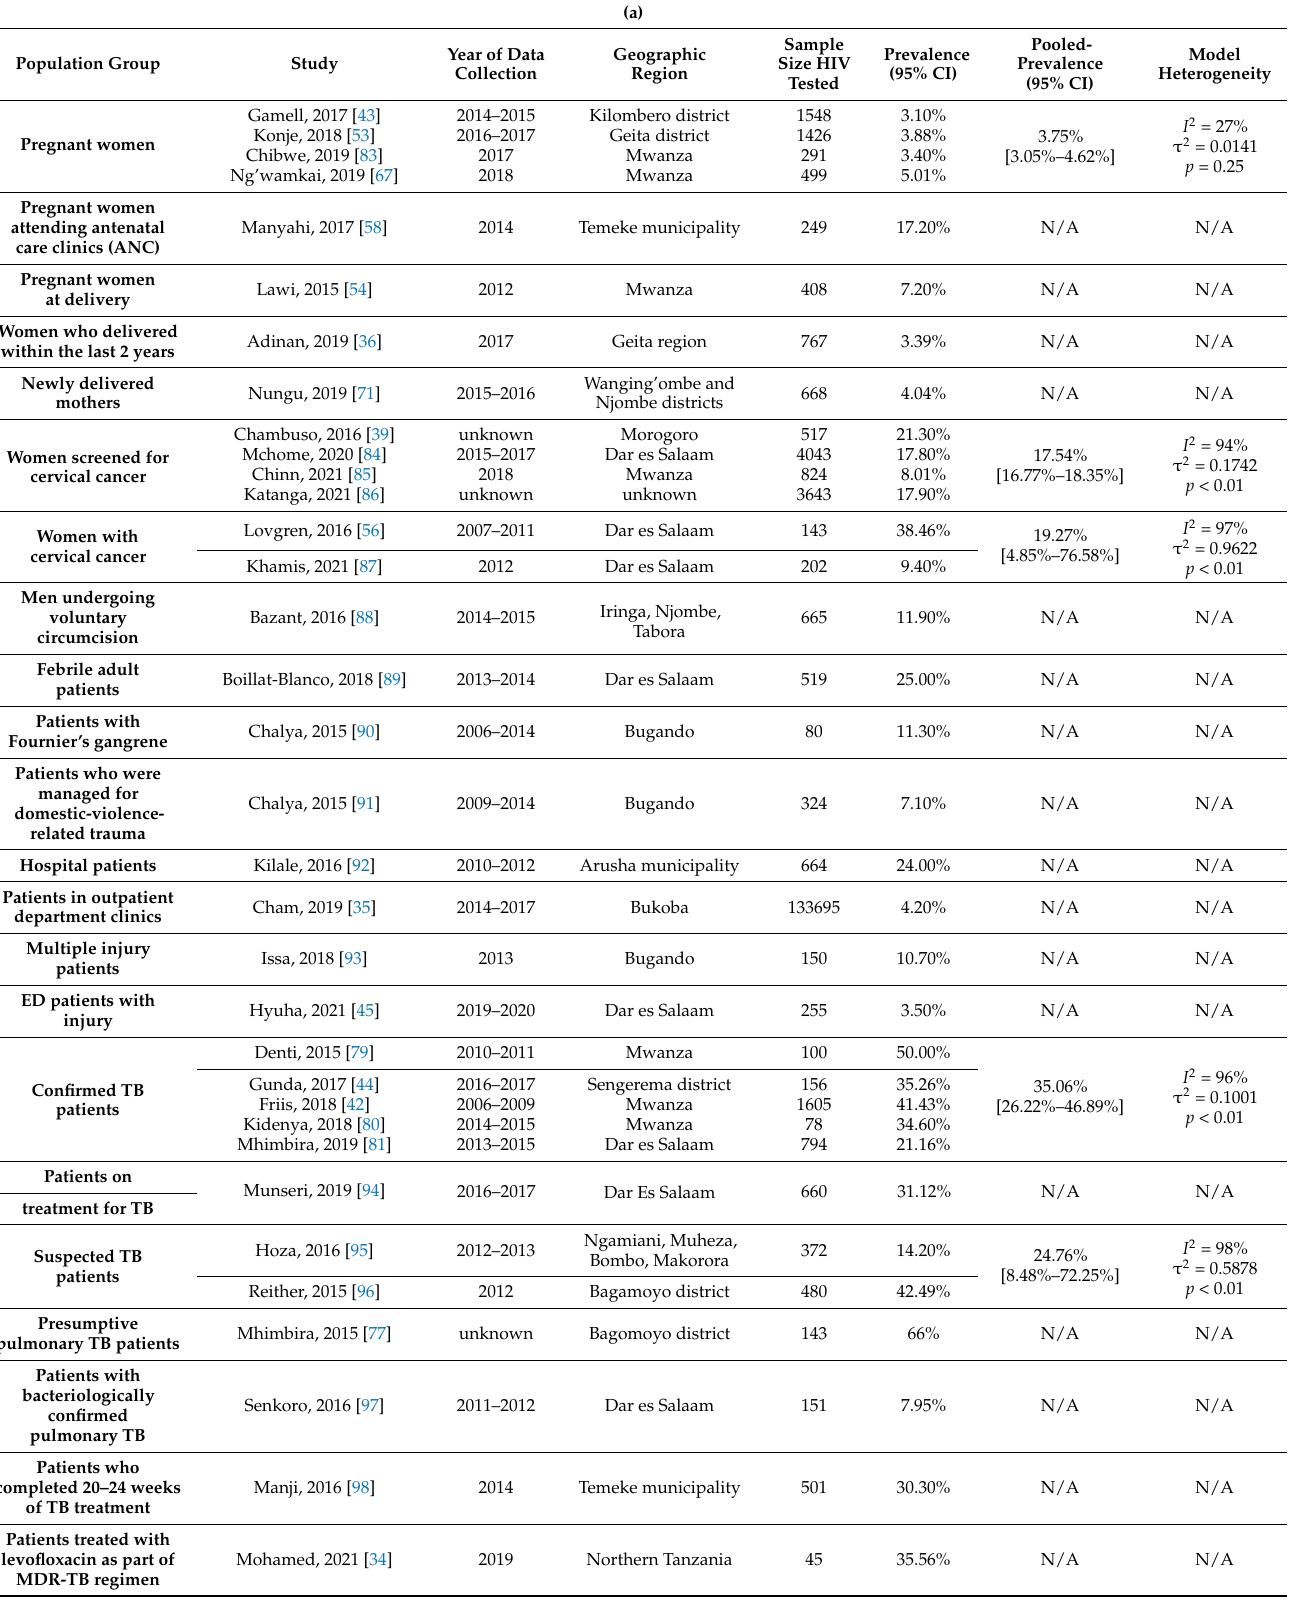
Table 3. (a) Study characteristics and HIV prevalence for clinical study population groups (n = 33) (‘n’ indicates number of population groups). (b) Study characteristics and HIV prevalence for nonclinical population groups (n = 12) (‘n’ indicates number of population